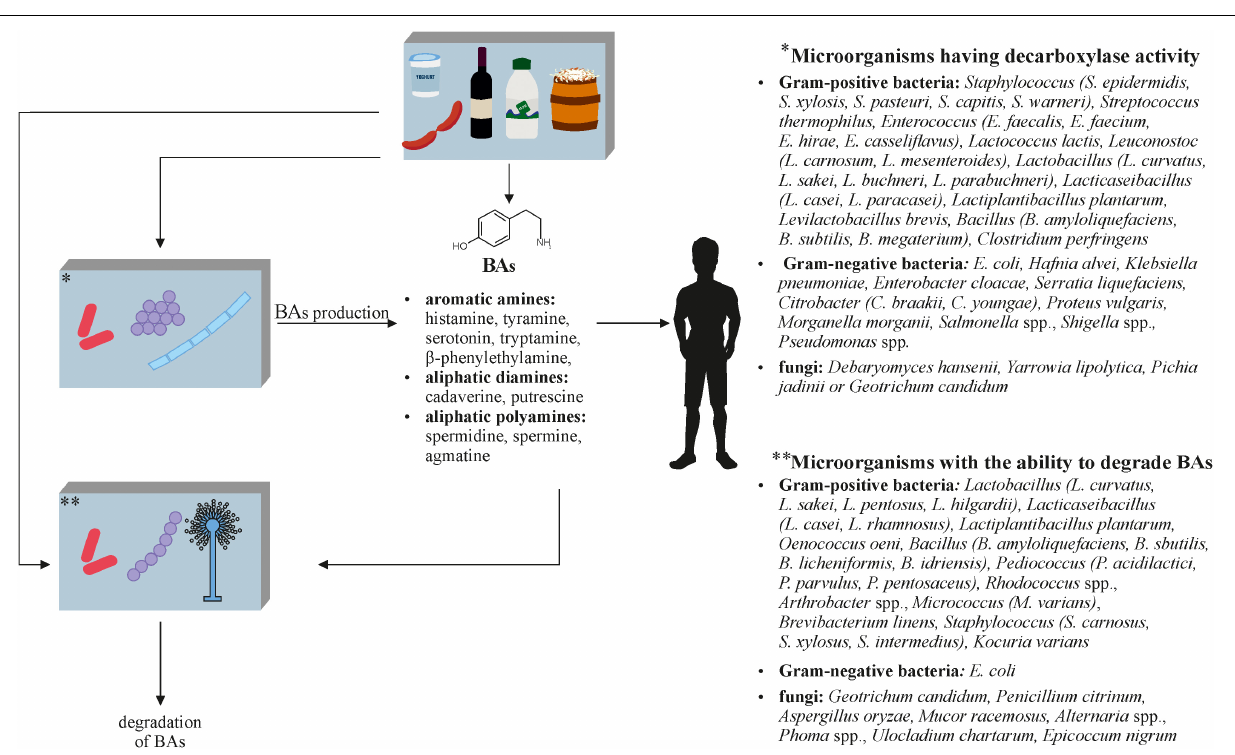
FIGURE 3 | The role of microorganisms in the metabolism of biogenic amines (BAs) in fermented foods (Smith, 1980; Latorre-Moratalla et al., 2010; Lorenzo et al., 2010; Spano et al., 2010; Cueva et al., 2012; Alvarez and Moreno-Arribas, 2014; De Mey et al., 2014; Zaman et al., 2014; Ladero et al., 2015; Ordóñez et al., 2016; Sun et al., 2016; Pugin et al., 2017; Ekici and Omer, 2018; Li et al., 2018; Barbieri et al., 2019; Mah et al., 2019; Park et al., 2019; Ruiz-Capillas and Herrero,